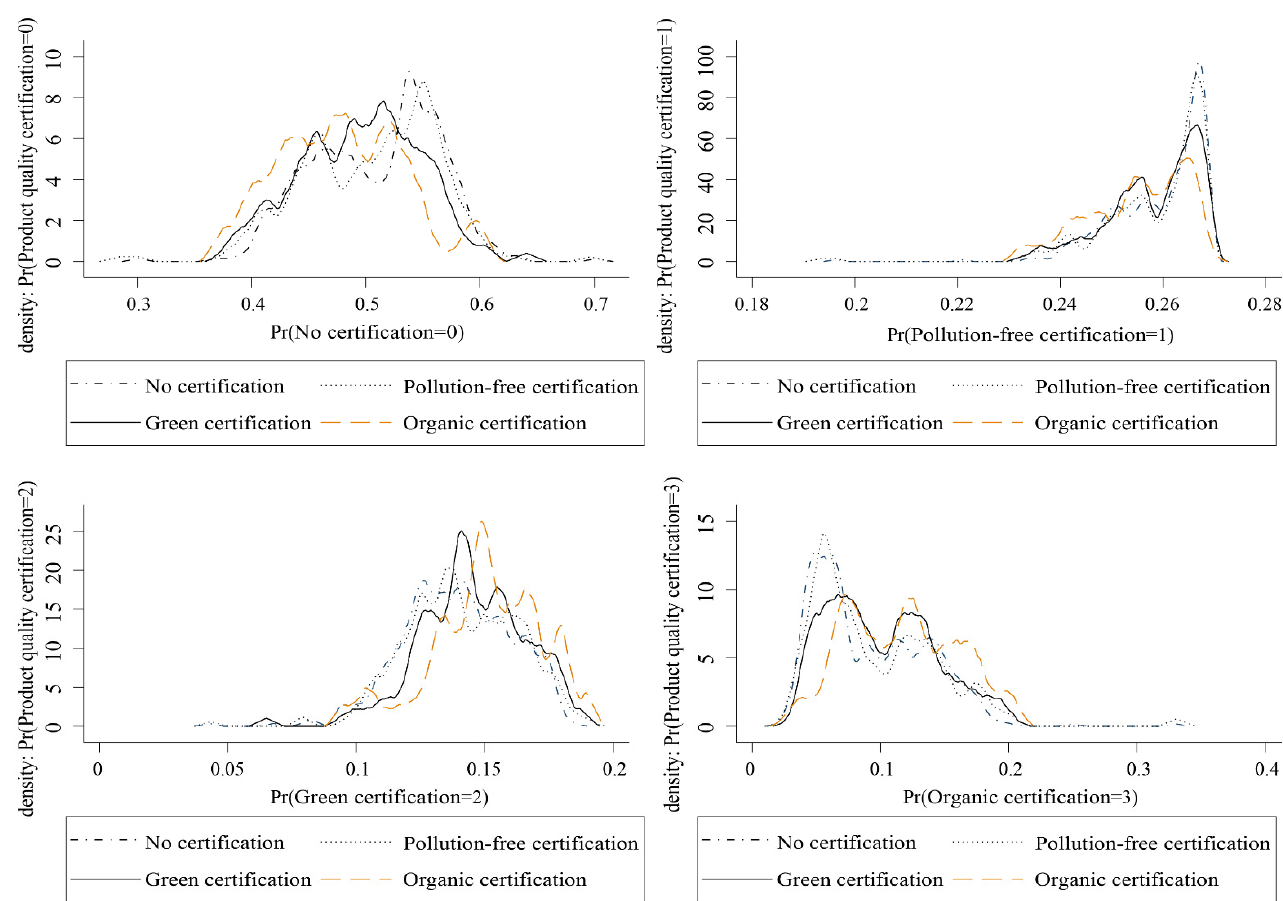
Figure 2. Conditional probability distribution of agricultural product quality certification. Table 5. Estimation results of the green production transition for kiwifruit grower’s certification